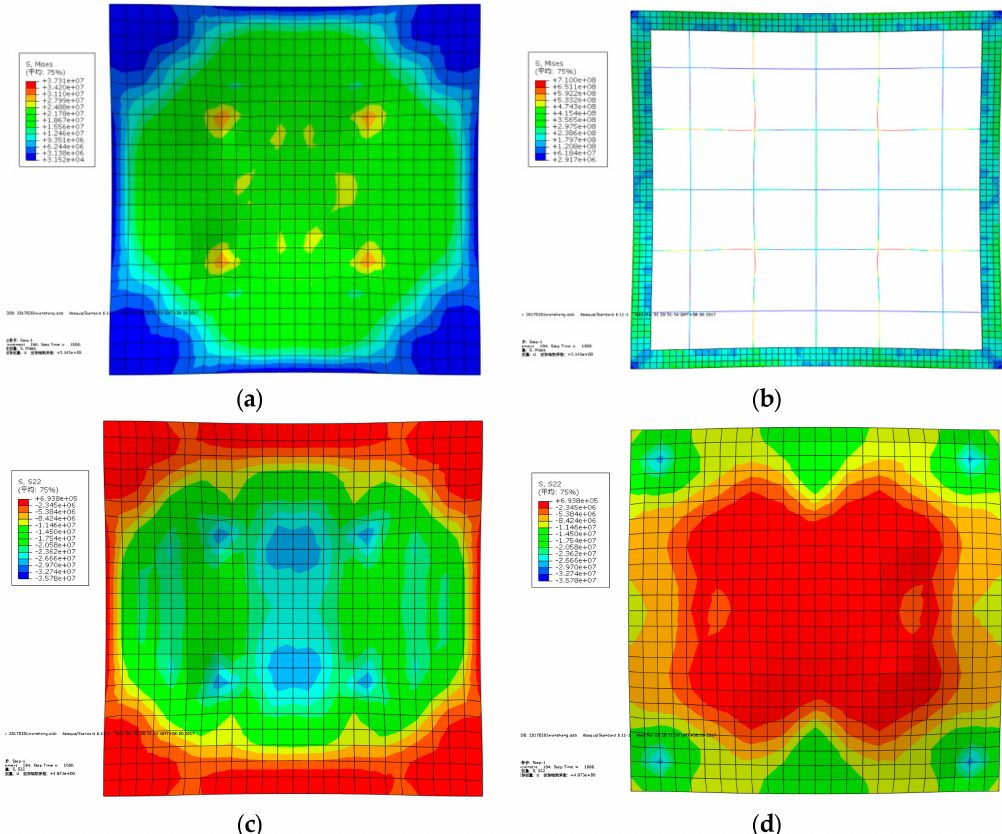
Figure 23. Mises stress contour figures of concrete and steel skeleton (damaged). ( a ) Mises stress in the concrete compression zone; ( b ) Mises stress of the reinforcement skeleton; ( c ) S22 stress in the concrete compression zone; ( d ) S22 stress in the concrete tension